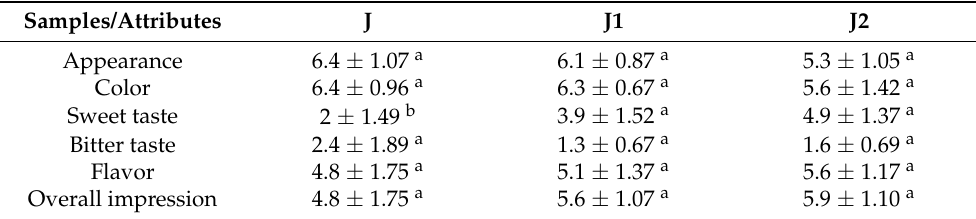
Table 8. Sensorial analysis of